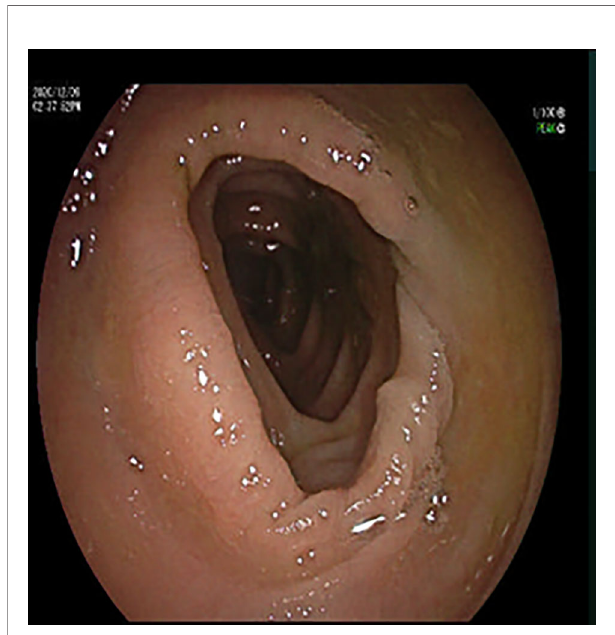
FIGURE 2 | Colonoscopy image: colonoscopy showed a smooth colonic mucosa surface, clear vascular texture, and no erosion or